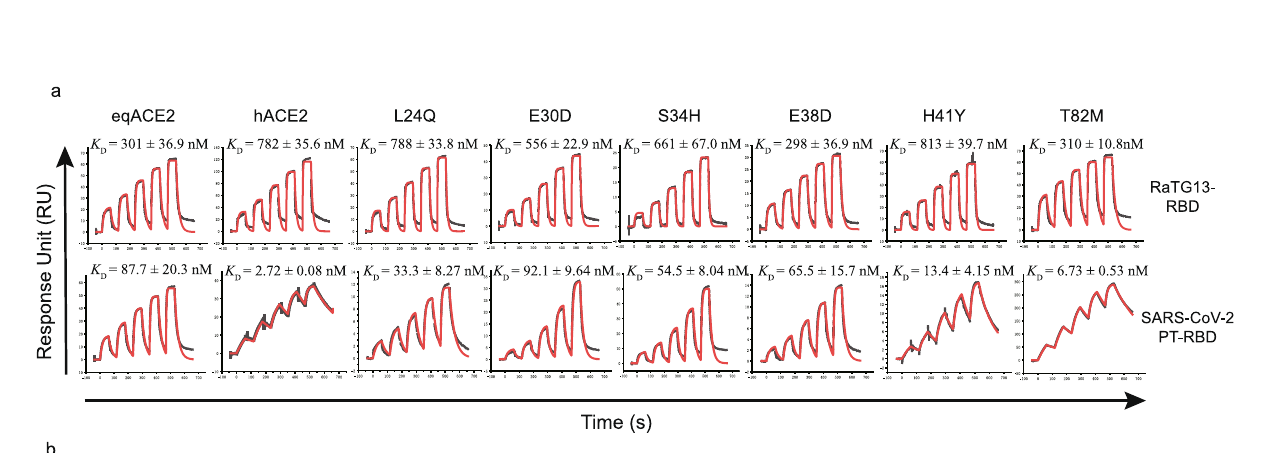
Fig. 4 Structural and functional analysis of key residues in the molecular interaction of eqACE2/PT-RBD and eqACE2/Omicron BA.1-RBD. a SPR analysis of the binding af fi nity of wt/mutated RaTG13-RBD and SARS-COV-2 PT-RBD with human or eqACE2. b – e Structural details of site 494 of the RBD and involved residues of eqACE2/SARS-COV-2 PT-RBD ( b ), eqACE2/RaTG13-RBD ( c ), hACE2/RaTG13-RBD ( d ) and hACE2/SARS-COV-2 PT-RBD ( e ). RaTG13-RBD, SARS-COV-2 PT-RBD, eqACE2 and hACE2 are colored purple, orange, cyan, and wheat, respectively. f SPR analysis of the binding af fi nity of SARS-COV-2 PT-RBD, Omicron BA.1-RBD and mutated SARS-COV-2 PT-RBD. g The structural details of eqACE2/SARS-COV-2 PT-RBD (orange) and eqACE2/Omicron BA.1-RBD (green) around the sites referred above each picture. Residues involved in the interaction are represented as sticks. h The original conformation surrounding G496 of eqACE2/Omicron BA.1-RBD (left) and the modelled conformation of G496S (right) are shown. The modelled S496 is colored in white and the modelled H-bonds are represented by yellow dashes. The water molecule was represented as red sphere. The disks indicate pairwise overlap of atomic van der Waals radii between atoms. Small green disks and large red disks indicate slight and signi fi cant van der Waals overlap. Everything else lies between those extremes. i Structural comparison of Y501 and the involved residues of hACE2/Alpha-RBD (left) and modelled N501Y substitution of eqACE2/SARS-COV-2 PT-RBD. The water molecule is shown as red sphere and the modelled Y501 is colored in white. The π - π interaction, actual polar interaction and putative polar interaction for modelled Y501 are represented with blue, red and yellow dotted lines, respectively. The disks indicate pairwise overlap of atomic van der Waals radii between atoms. The dissociation constant ( K D ) of each binding test is calculated from 3 independent repeats and are presented as mean ± SD. Source data are provided as a Source Data fi le.